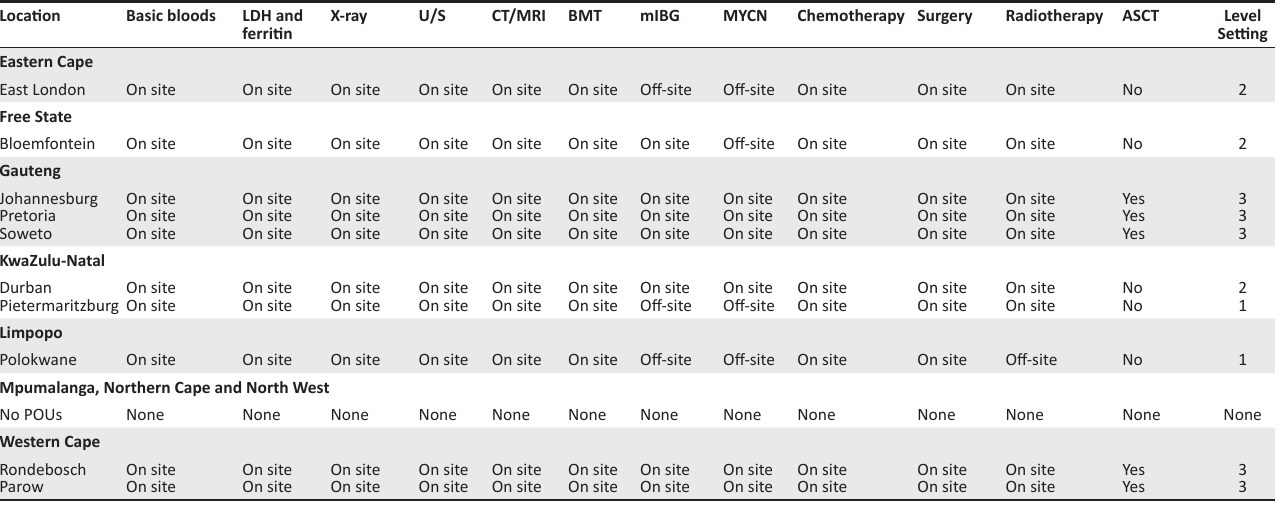
TABLE 10: Evaluation of paediatric oncology units according to the International Society for Paediatric Oncology-Paediatric Oncology of Developing Countries resource settings for neuroblastoma diagnosis, staging and risk stratification. Location Basic bloods